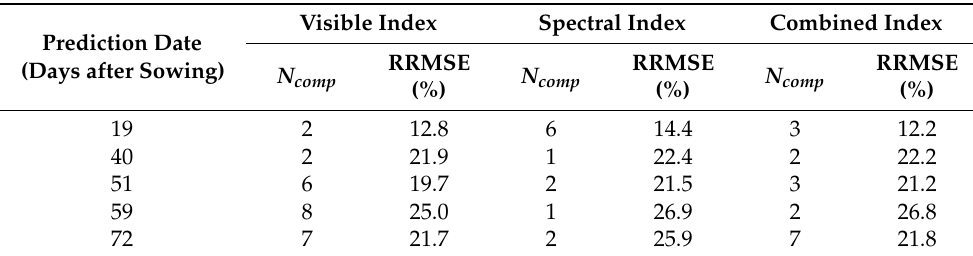
Figure 7. The mean of cross-validated relative root mean square error (RRMSE) of the number of components in training the PLSR model to estimate the leaf area index of wheat. The mean RRMSE of each number of components was calculated from the 10 repeats of 8-fold cross-validations of the PLSR models. The models were trained using mono-temporal datasets of visible ( red ), spectral ( green ), and combined ( blue ) indexes at prediction dates (days after sowing, DAS). Table 4. The optimal number of components ( N comp ) and the corresponding relative root mean square error (RRMSE) in training PLSR models to estimate the leaf area index of wheat. The models were developed using the mono-temporal datasets of the visible, spectral, and combined indexes at prediction